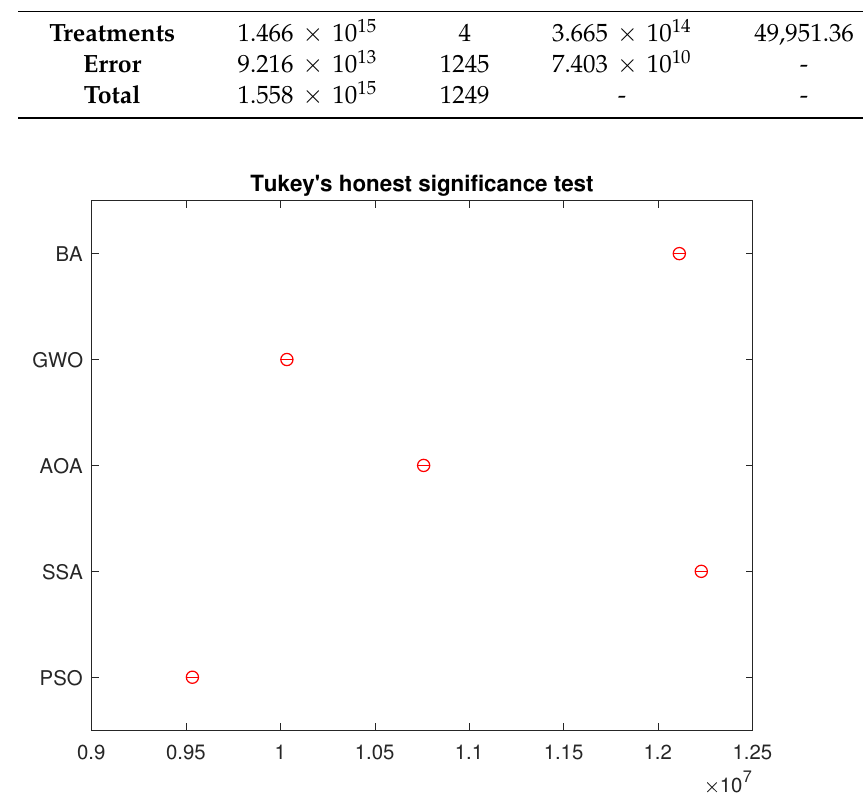
Figure 8. Tukey’s Honest Significance Test from the 250 Simulations.